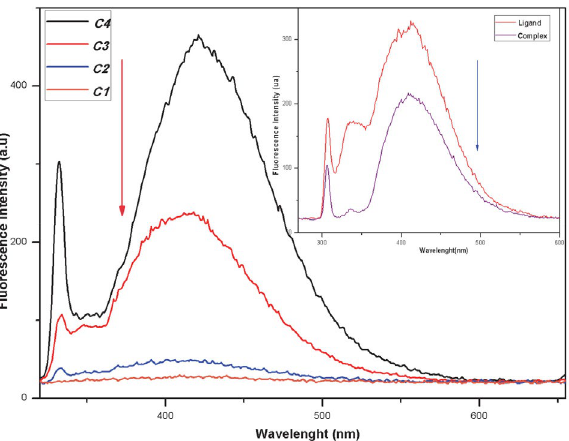
Figure 4. Fluorescence spectra of the complex (recorded in DMSO at λ ex = 330 nm) at different concentrations c 1 = 0.7 ∙ 10 –4 M, c 2 = 1.6 ∙ 10 –5 M, c 3 = 0.26 ∙ 10 –5 M, c 4 = 0.4 ∙ 10 –6 M. The inset shows the spectra of complex and ligand (in DMSO at λ ex = 303 nm) at con- centration 1.6 ∙ 10 –5